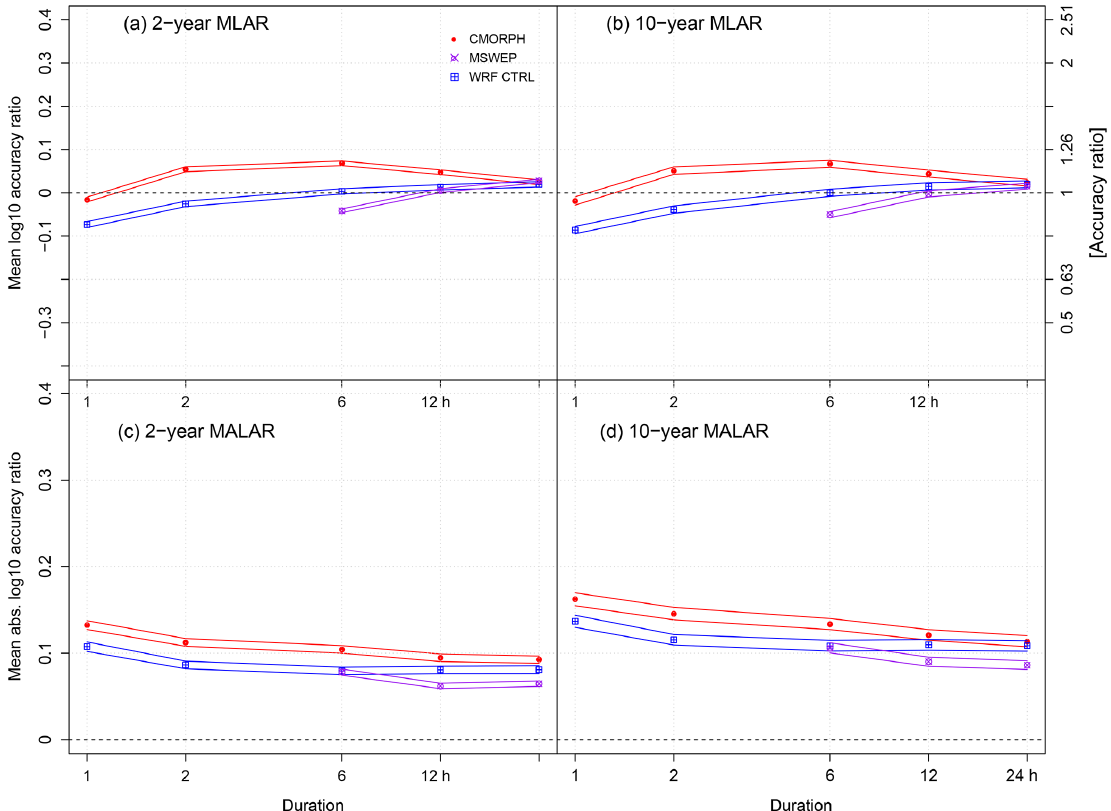
Figure 5. Summaries of MLAR and MALAR for the empirical 50th (2-year return level) and 90th percentile (10-year return level) of annual maximum rainfall intensities between each MSWEP, CMORPH, and WRF CTRL gridded dataset and station observation for 1 to 24h accumulation durations. Solid lines indicate the 95% confidence interval. Perfect performance is indicated by the horizontal dashed